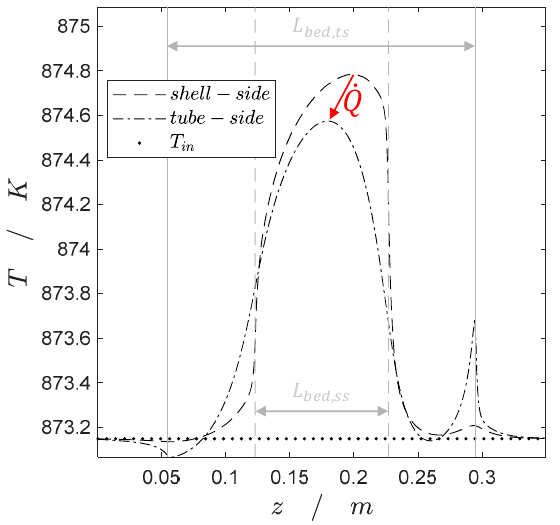
Figure 5. Radial averaged temperature profiles of the shell-side and the tube-side of the PBMRint along the axial coordinate ( x C